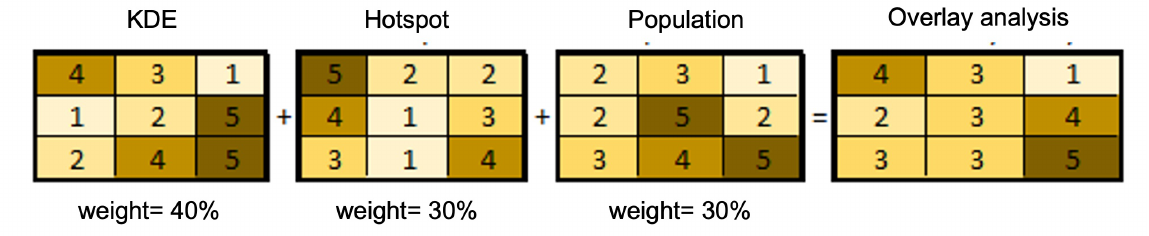
Figure 5. An example of the overlay analysis of selected